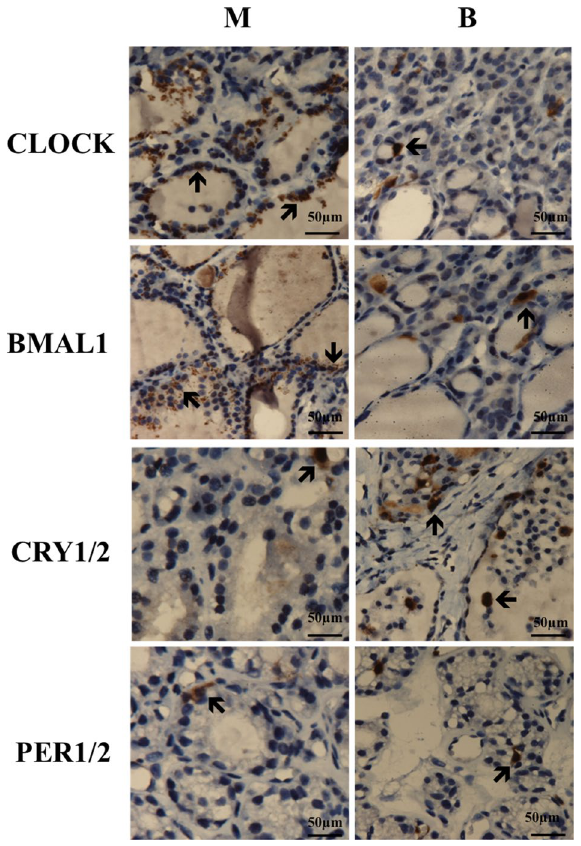
with arrows. M malignant nodule group; B benign nodule group; N adjacent normal